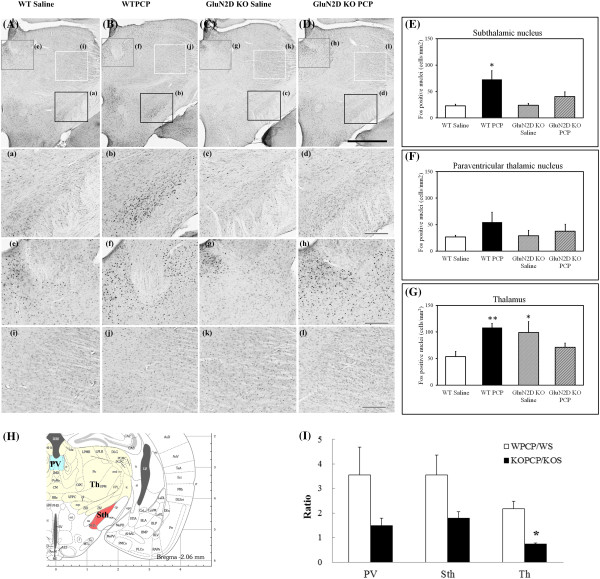
Analyses of Fos induction in various brain regions in wildtype and GluN2D knockout mice. The photomicrographs illustrate the immunohistochemical labeling of Fos in coronal sections of the thalamus. The boxes are shown in panels a-i are at higher magnification. A schematic representation of the paraventricular thalamic nucleus (PV), thalamus (Th), and subthalamic nucleus (Sth) is shown in panel H. The number of Fos-positive cells per square millimeter was determined in the respective brain areas (E–G) and normalized to the number in saline-treated mice (I). Open bars, wildtype (WT) mice; closed bars, GluN2D KO mice. The results are expressed as the mean ± SEM ratio between the density of Fos-positive neurons in PCP-treated mice to the density of Fos-positive neurons in saline-injected mice (n = 4–6). One-way ANOVA of the PCP-induced increase in Fos-positive cells indicated a significant effect of genotype in the thalamus (Kruskal-Wallis nonparametric ANOVA followed by Scheffe’s test, p = 0.0209, unequal variance). *p < 0.05. Scale bars = 1 mm and 200 μm in panel D and d, respectively. The brain regions are defined as indicated by the images in the atlas [10].